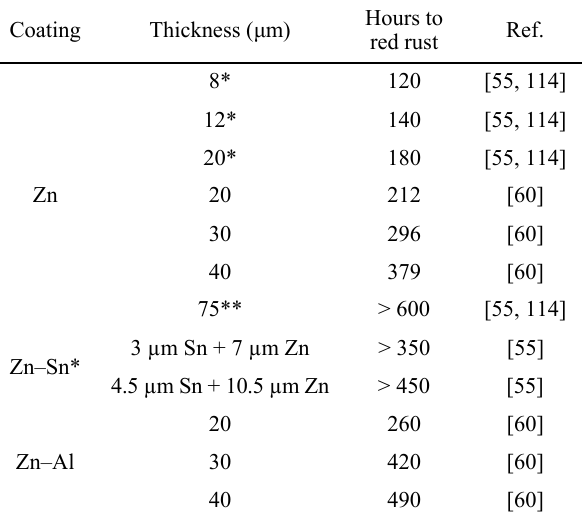
Table 6 Hours to red rust in 5% neutral salt spray test (ASTM B-117) of mechanically plated steel